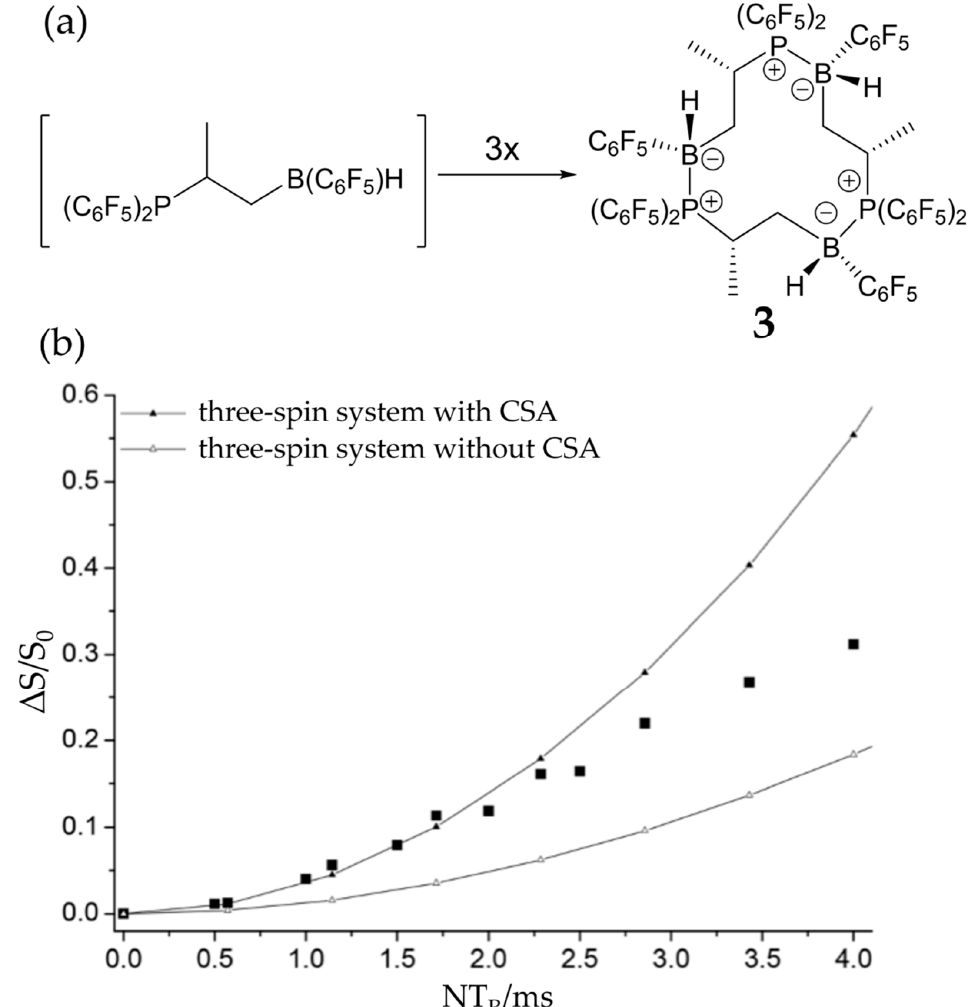
Figure 17. ( a ) Formation of FLP-cyclotrimer 3 and ( b ) 31 P– 31 P DRENAR build-up curve for 3 . Solid squares: experimental data points. Solid curves: simulated DRENAR curve based on the intermolecular dipole–dipole coupling only (lower curve) and with additional consideration of the 31 P CSA ( ∆ σ = 99 ppm), leading to an improved agreement with the experimental data. Reproduced from Reference [81].